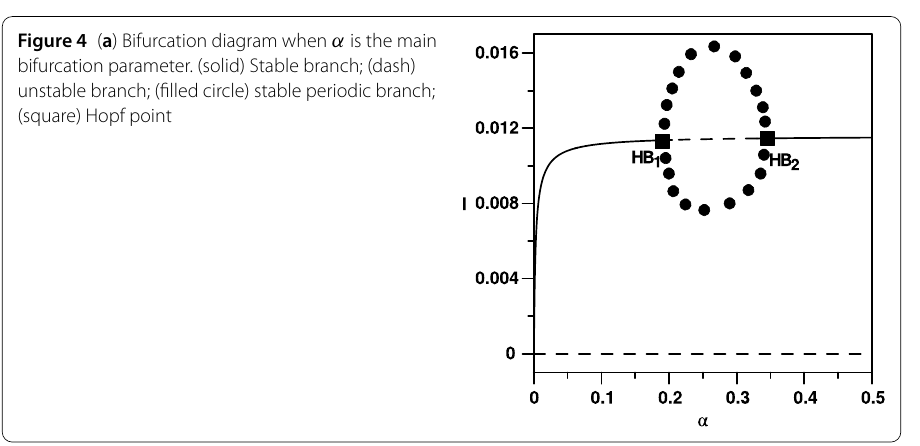
increases the range of periodic behavior which will disappear if the strength falls below a critical point. The rest of the curves in Fig. 6 shows that an increase in the basic transmis- sion rate ( β 0 ) would increase the range of periodic behavior, and no periodic behavior